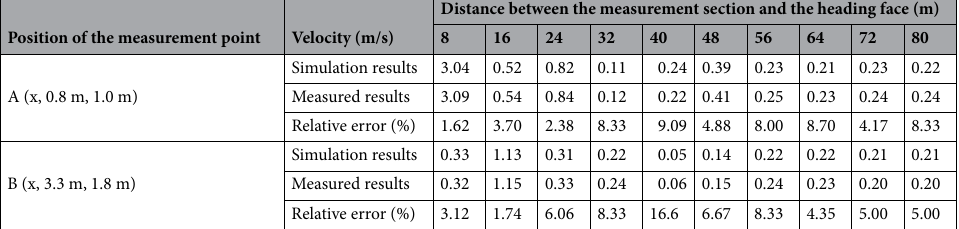
Table 2. Simulated and measured values of airflow velocity at the measurement points.